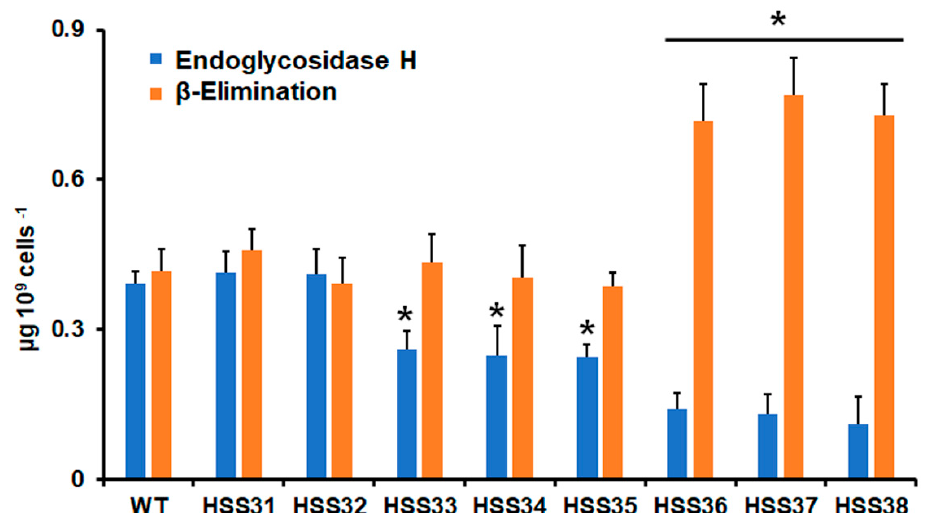
Figure 3 . The N -linked and O -linked glycan content in the wild-type control and ROT2 -silenced strains . The N -linked glycans were trimmed from yeast-like cell walls by incubating with endogly- cosidase H, or O -linked glycans were removed by β -elimination. In both cases, the sugar content was quantified as described in Section 2.5. Data are represented as mean ± SD of three independent experiments performed in duplicates. * p < 0.05 when compared to WT, HSS31, or HSS32 cells.